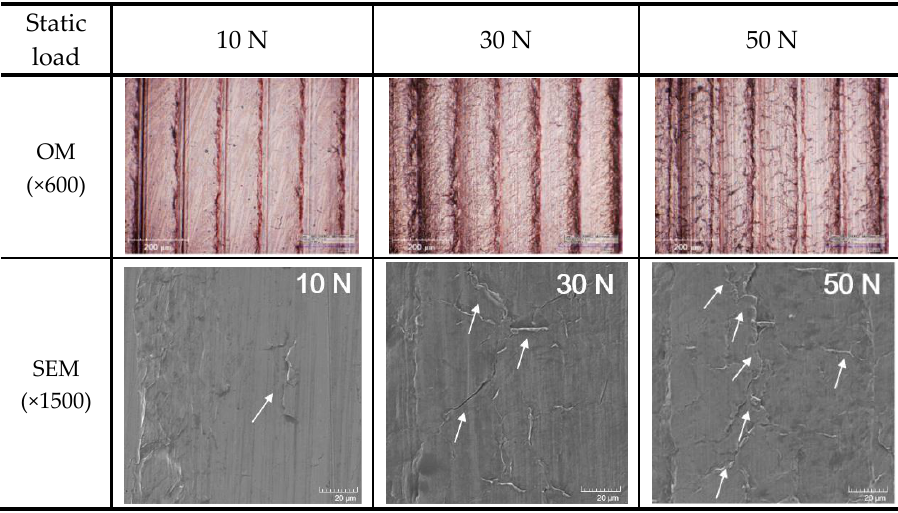
Figure 16. The effect of the static load on the surface morphologies and mechanical overlapping by UNSM treatment.